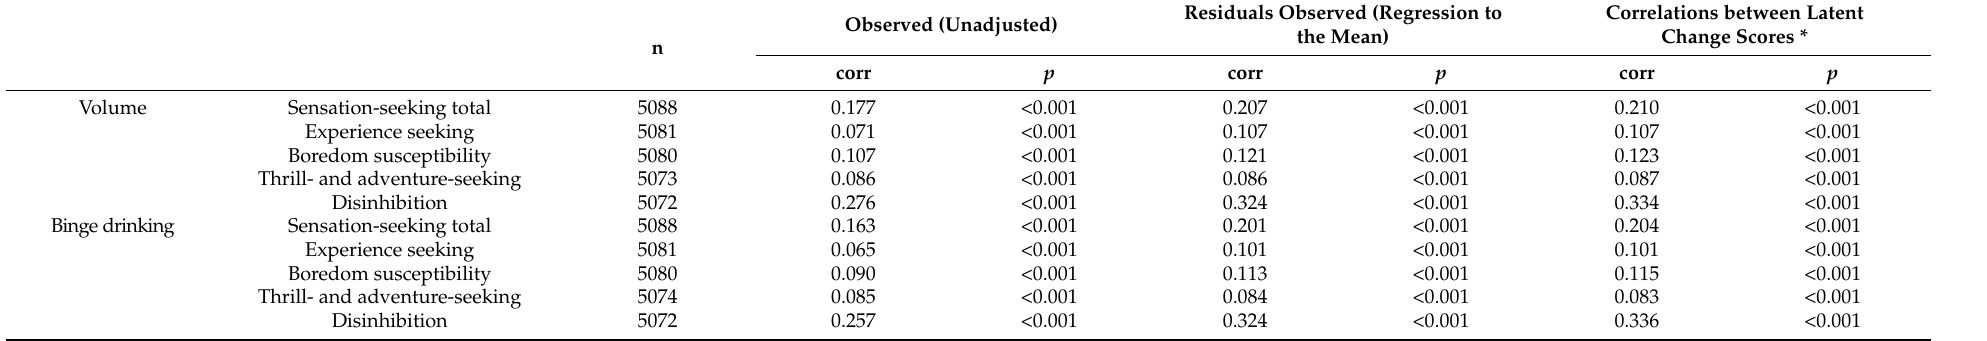
Residuals Observed (Regression to the Mean)